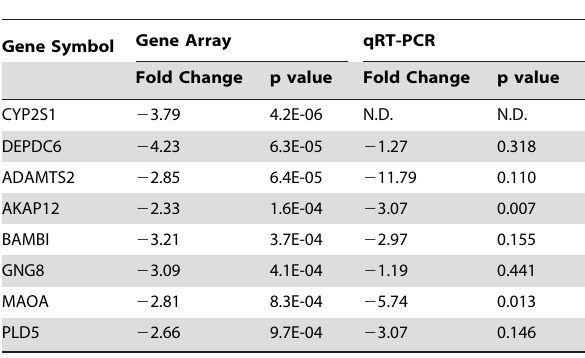
Table 1. Summary of microarray and qRT-PCR analyses comparing differences in gene expression between stable BE(2)M17 clones expressing miR-142 and